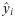
Scatterplot of clone trajectories of animal RQ5427 displayed in terms of ln y^i, the log mean abundance of clone i, and z^i, the number of samples in which clone i is undetected.The trajectory of each clone i is represented by a symbol located at a coordinate determined by its value of ln y^i and z^i. A trajectory of a clone that exhibits one absence within months 8 − 67 is shown in the inset. The first sample at month 2 is excluded because only long-term repopulating clones are considered. Clones that are absent in all eight samples are also excluded, so the largest number of absences considered for animal RQ5427 is 7. The dashed black line denotes ln Y^z, where Y^z is the average of y^i calculated over i within each bin of z as shown in Eq (15). When later analyzing Y^z, Y^0 (red circles) is not included.